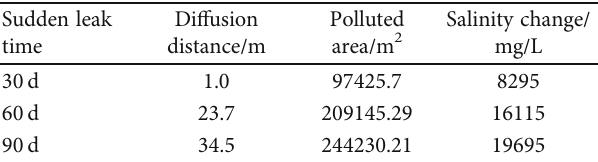
Figure 12: Relationship curve between the di ff usion distance of concentrated brine, the ground-water head di ff erence, and the salinity at the outer wall of the underground storage after 70 years of long-term penetration. Table 8: Partial simulation data of di ff erent sudden leak times when the groundwater head di ff erence is 10